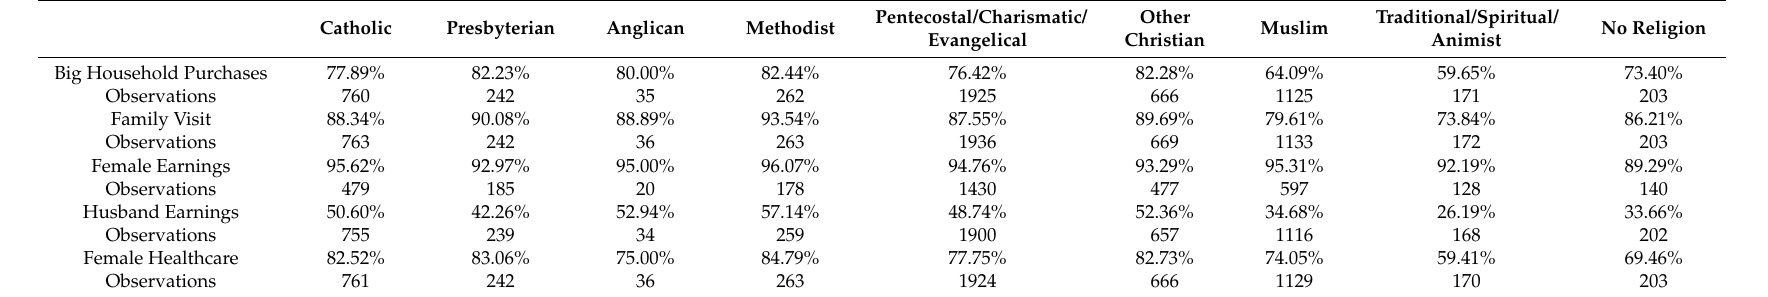
Table 2. Female Decision-Making Power by Religious